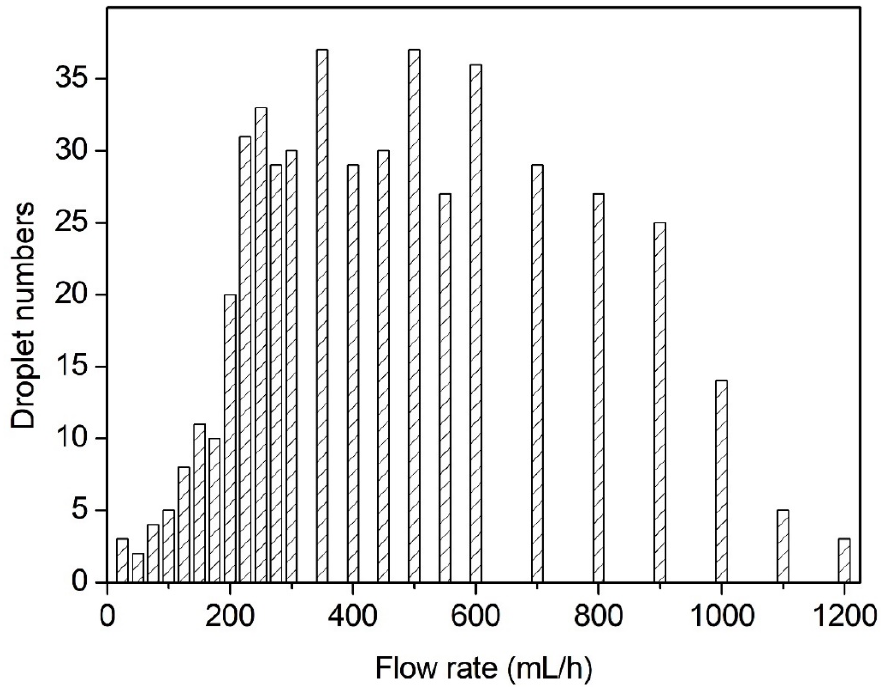
Figure 7. The numbers of breakup droplets at different volume flow rates (21G nozzle, voltage of 28 kV, 35 wt. % concentration).